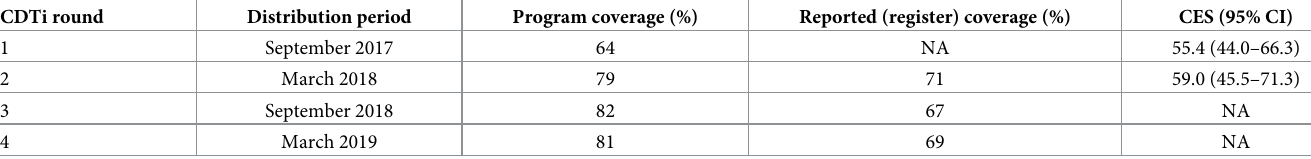
Table 3. Ivermectin treatment coverages over four treatment